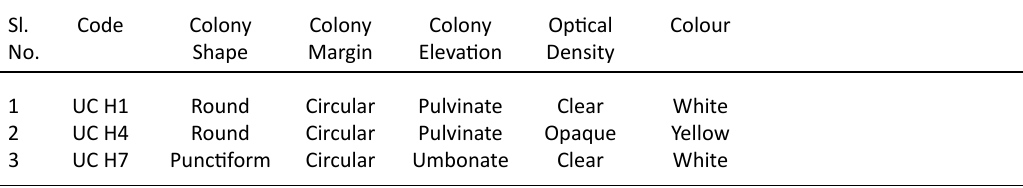
Table 2. Micromorphological characteristics of endophytes from H. ada-kodien